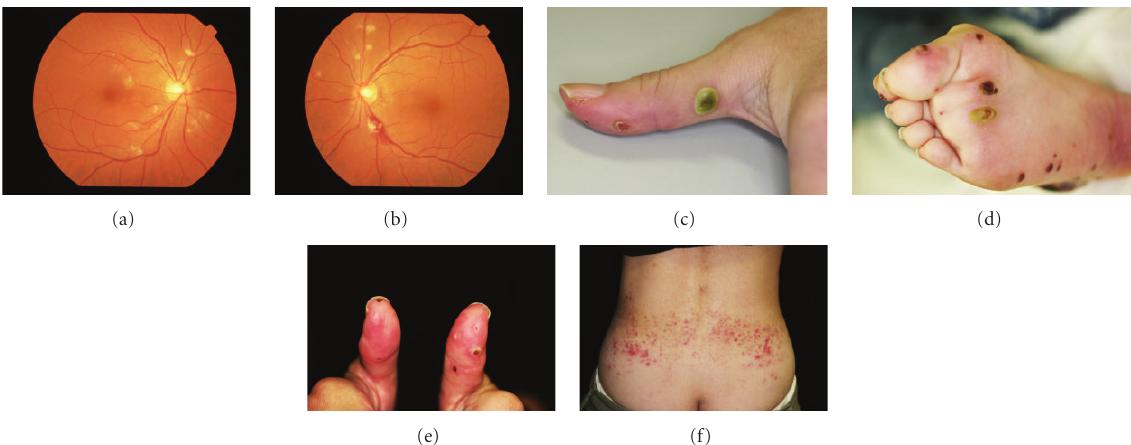
Figure 1: Adverse events after tocilizumab therapy. (a), (b) Photographs show the bilateral fundus images of retinopathy with bilateral multiple cotton-wool spots and retinal hemorrhages around the optic disc. (c), (d), and (e) Rashes on the palms and planta pedis resemble pustulosis palmoplantaris, and (f) di ff use pruritic erythema around the lumbar region appeared 20 days after the first infusion of tocilizumab. (g) Skin ulceration on the right external malleolus appeared immediately after the second infusion of tocilizumab.